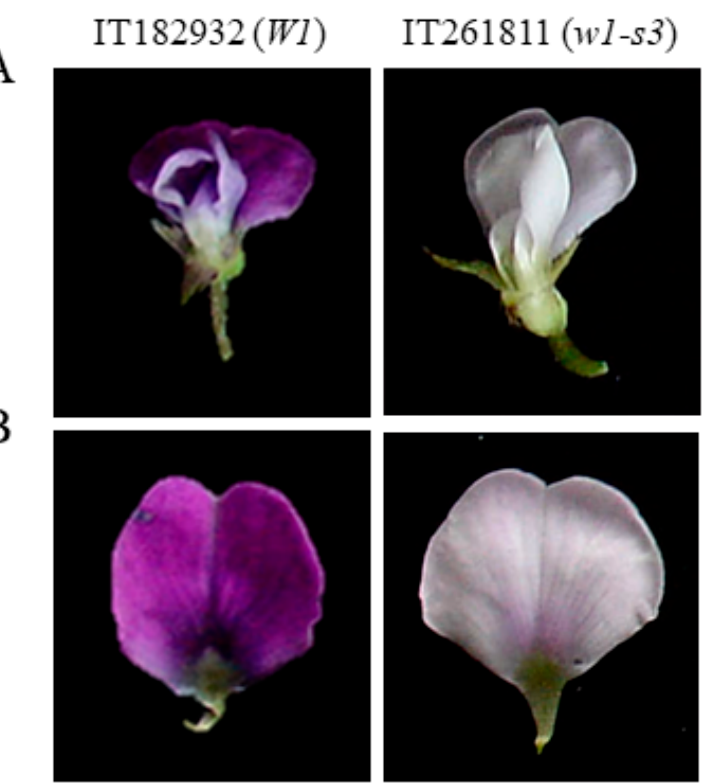
Figure 1. Photographic images showing the flower colors of the plant materials. Plant materials of wild soybean accessions IT182932 (purple flower) and IT261811 (pinkish-white). ( A ) A whole flower. ( B ) A banner petal.